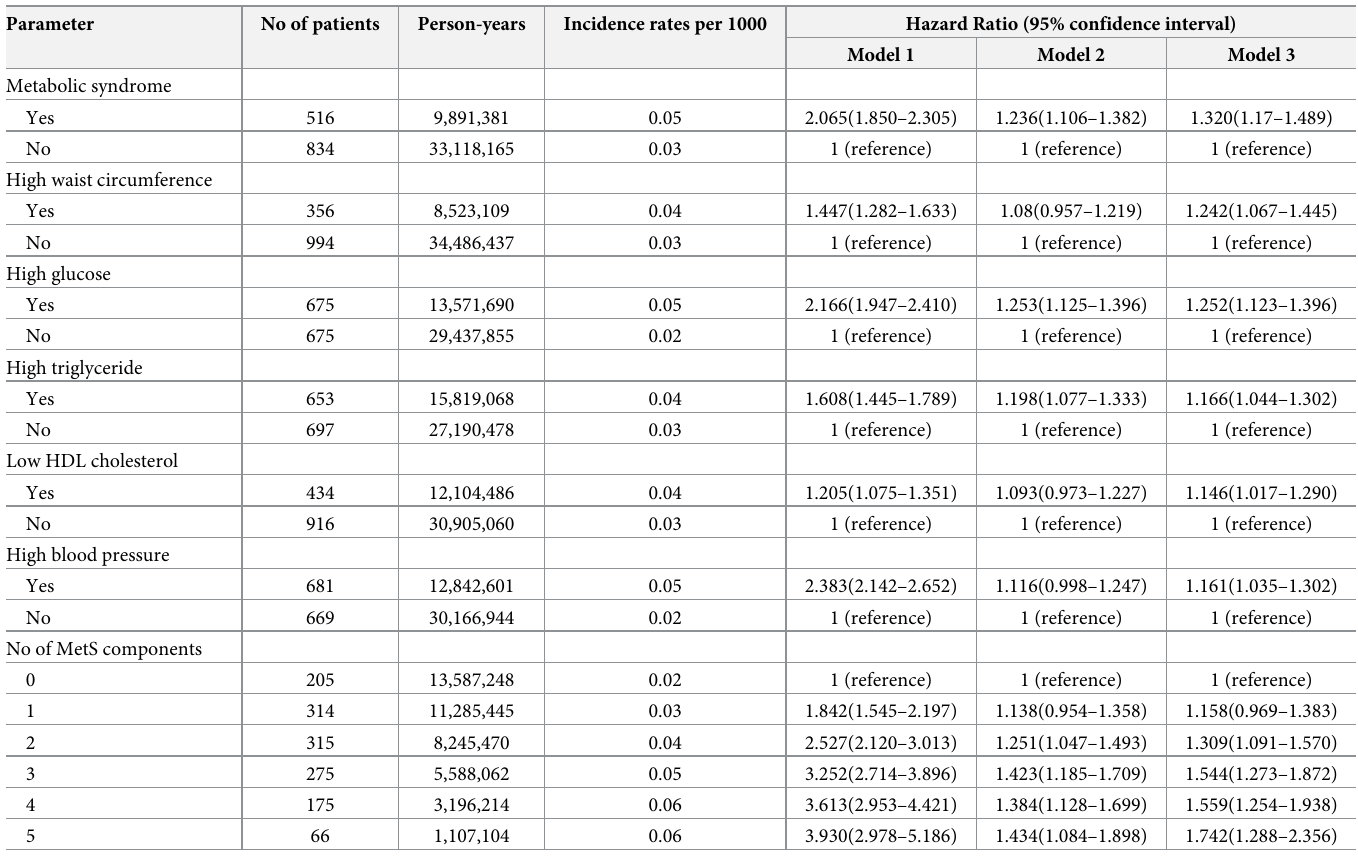
Table 2. Multivariate Cox proportional hazard model for incidence of larynx cancer according to the metabolic syndrome